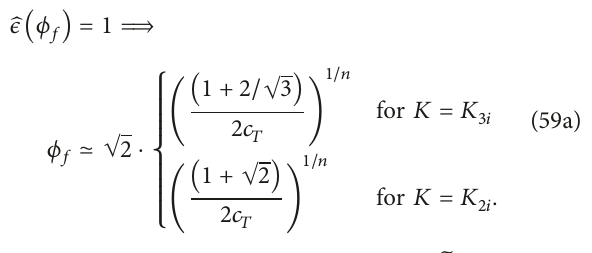
/̂𝐻 2 𝐼 as a function of